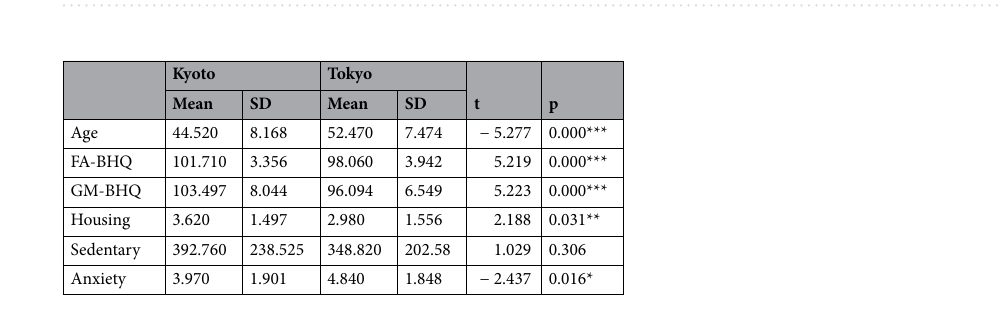
Table 1. Student’s t test (two-tailed) and chi square test for the statistical difference between male and female participants.